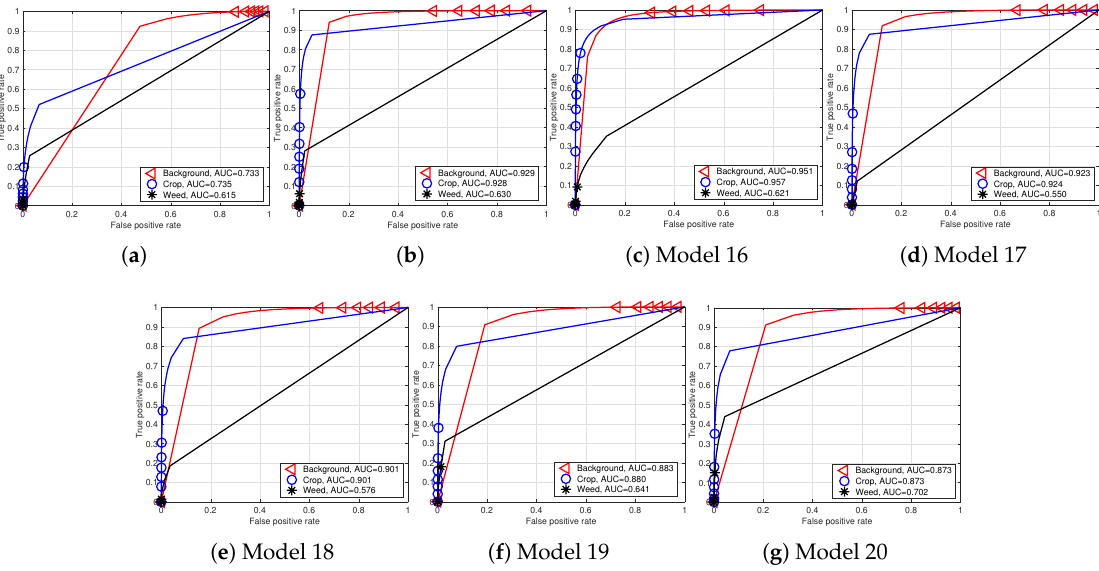
Figure 12. Performance curves of Sequoia dataset models (Models 14–20). ( a ) Model 14; ( b ) Model 15; ( c ) Model 16; ( d ) Model 17; ( e ) Model 18; ( f ) Model 19; ( g ) Model